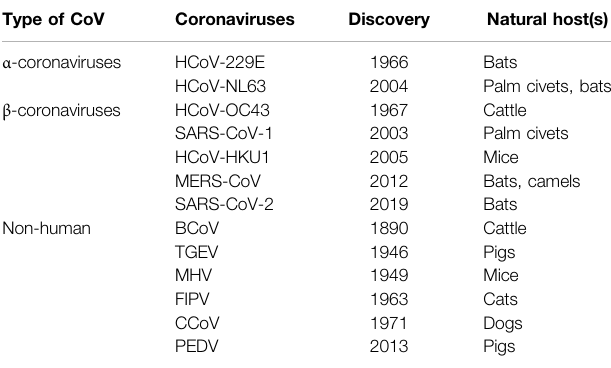
TABLE1| Classi fi cationofdifferenttypesofCoVswiththeirvariantsname,yearof discovery, and host organism. Type of